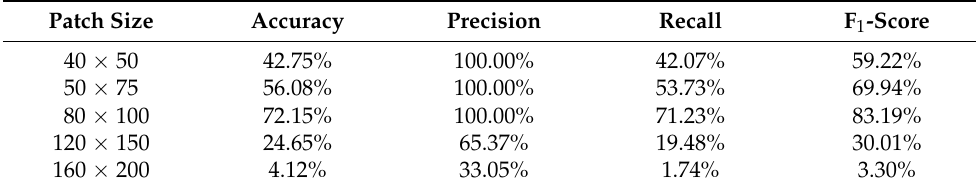
Table 1. Performance evaluation on the UMCD dataset for Patch P size. All rows generate a co- occurency matrix using a circumference radius r =